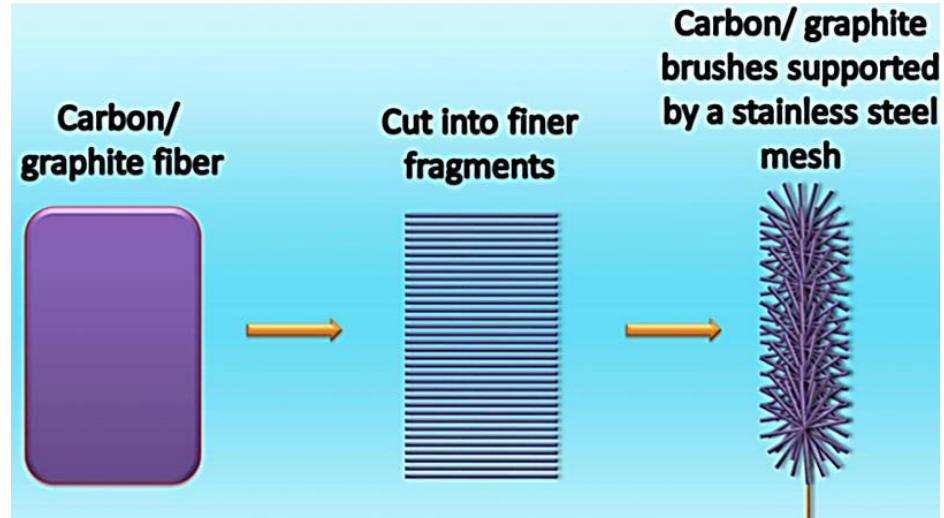
Figure 8. Energy diagram of energy devices and benefits of microbial fuel cells [135]. Reproduced with permission from Elsevier.